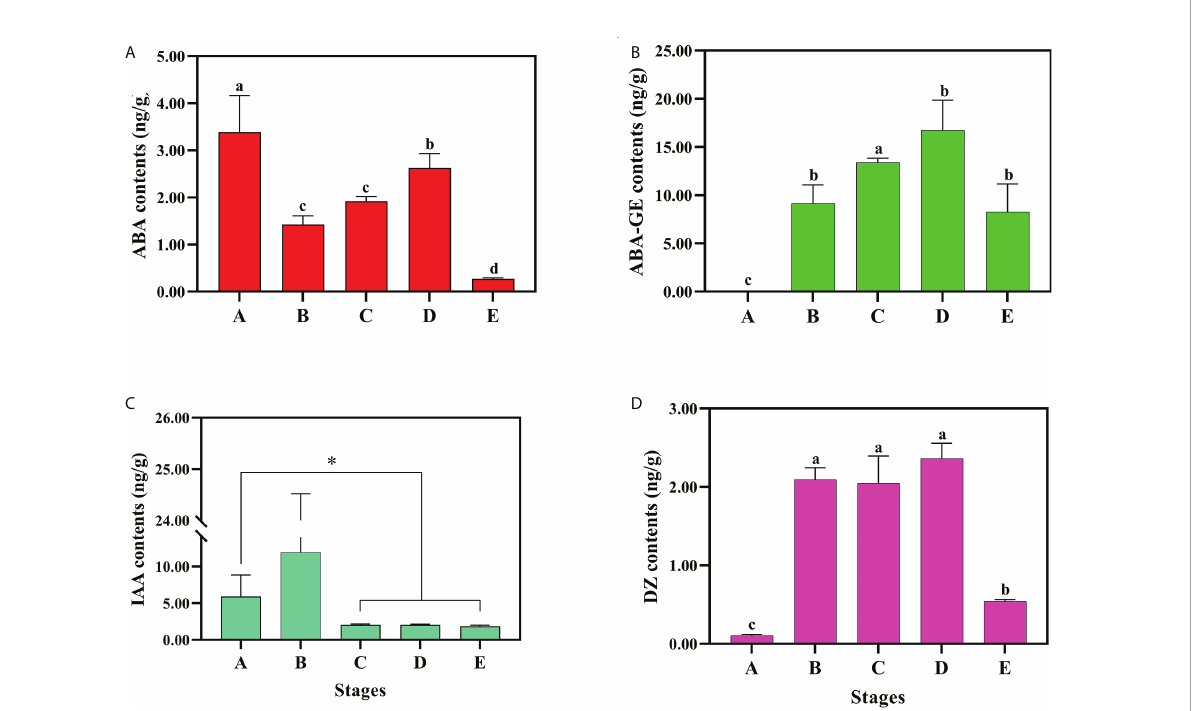
FIGURE 7 The endogenous hormone content There were contents changes of bioactive or inactive (A) ABA, (B) ABA-GE, (C) IAA and (D) DZ. Three biological replicates for each sample and analyzed by ANOVA. Values are reported as means ± SE (n = 3). * indicate signi fi cant difference (P <